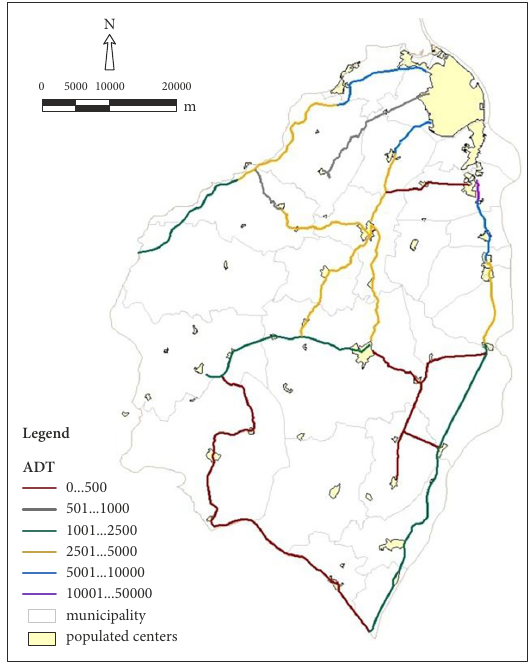
Figure 1. Road network of the Atlantic Department Figure 2. ADT in the road network of the Atlantic Department